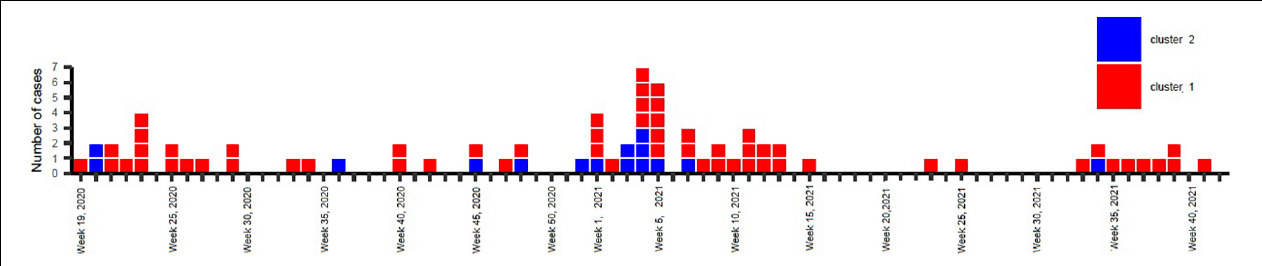
FIGURE 1 | Temporal distribution of PIMS cases by cluster from May 1st, 2020 (Week 19, 2020) to September 30, 2021 (Week 40, 2021).